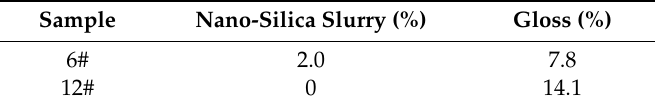
Figure 3. Effect of drying time on gloss of the coating. Table 5. Effect of nano-silica slurry on gloss of the coating.